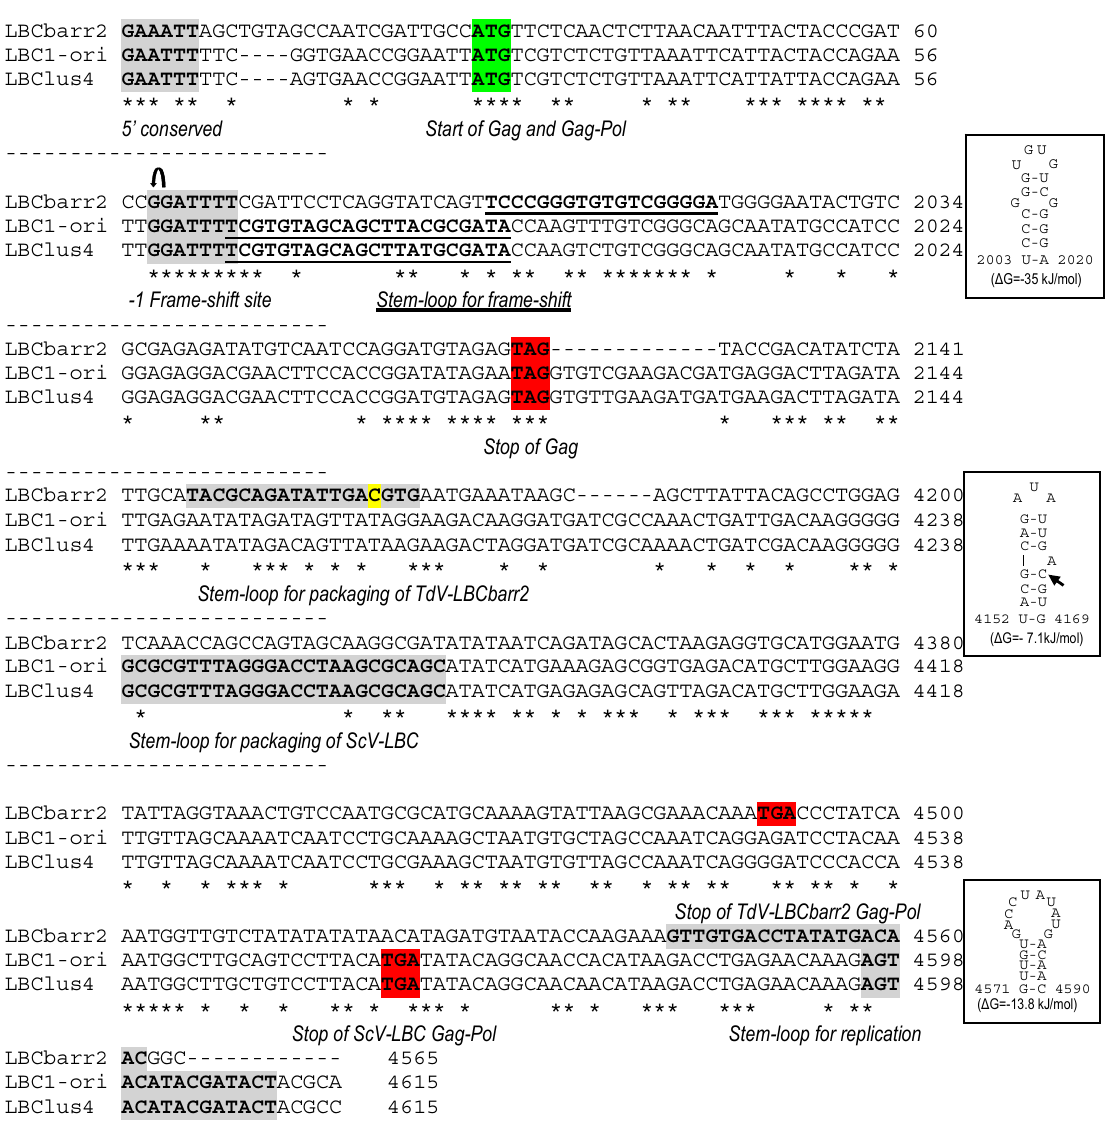
Figure 1. Partial multiple sequence alignment between ScV-LBC1-original, ScV-LBClus4, and TdV- LBCbarr2 (+) strand nucleotide sequences (cDNA). The full sequence alignment is presented in Sup- plemental Material (Figure S1). 5’GAA(A/T)TT conserved motif (5’ conserved), translation initiation (start of Gag and Gag-Pol), termination (stop of Gag or Gag-Pol) codons, ribosome frameshifting site ( − 1 frameshift site), frameshifting associated sequence (stem-loop for frameshift), packaging sig- nal (stem-loop for packaging), and replication signal (stem-loop for replication) are indicated, shaded and/or underlined in the nucleotide sequence. Different residue in LBCbarr2 with respect to LBCbarr1 virus is yellow shaded. , ribosomal frameshift. Asterisks (*) indicate identical nucleotide positions. The secondary structures of the putative cis signals for frameshifting, packaging, and rep- lication of TdV-LBCbarr2 are displayed at the right of the sequence panel. TdV-LBCbarr2 canonical genome length (4565 bp) is slightly shorter than that of ScV- LA (4580 bp), TdV-LA (4591 bp), and ScV-LBC (4615 bp). Its genome organization is sim- ilar to that described for ScV-LA1-original, containing two ORFs [11]. The first ORF (from nt 28 to nt 2124) belongs to the coat (Gag) protein of the virion, and the second ORF (from nt 2157 to nt 4489) belongs to the viral RNA-dependent RNA polymerase (RdRp). This polymerase is expected to be synthetized as a Gag-Pol fusion protein by a − 1 ribosomal frameshift at the conserved frameshifting site (or slippery site) located upstream of the Gag ORF stop codon (1977GGAUUUU1983) (Figures 1 and S1), as previously described for ScV-LA1-original and ScV-LBC1-original [4,7,11,12]. These different ORF assignments were done by also considering the amino-acid sequence homology of the Gag-Pol fusion protein of both TdV-LBCbarr to those of L viruses from Saccharomyces (see below). There are other important regions in TdV-LBCbarr genomes that are similar to those highly conserved in ScV-LA and ScV-LBC genomes [4,6,12,13,16]: (i) a 18-nt stem-loop region involved in frameshifting (2003TCCCGGGTGTGTCGGGGA2020), that is located